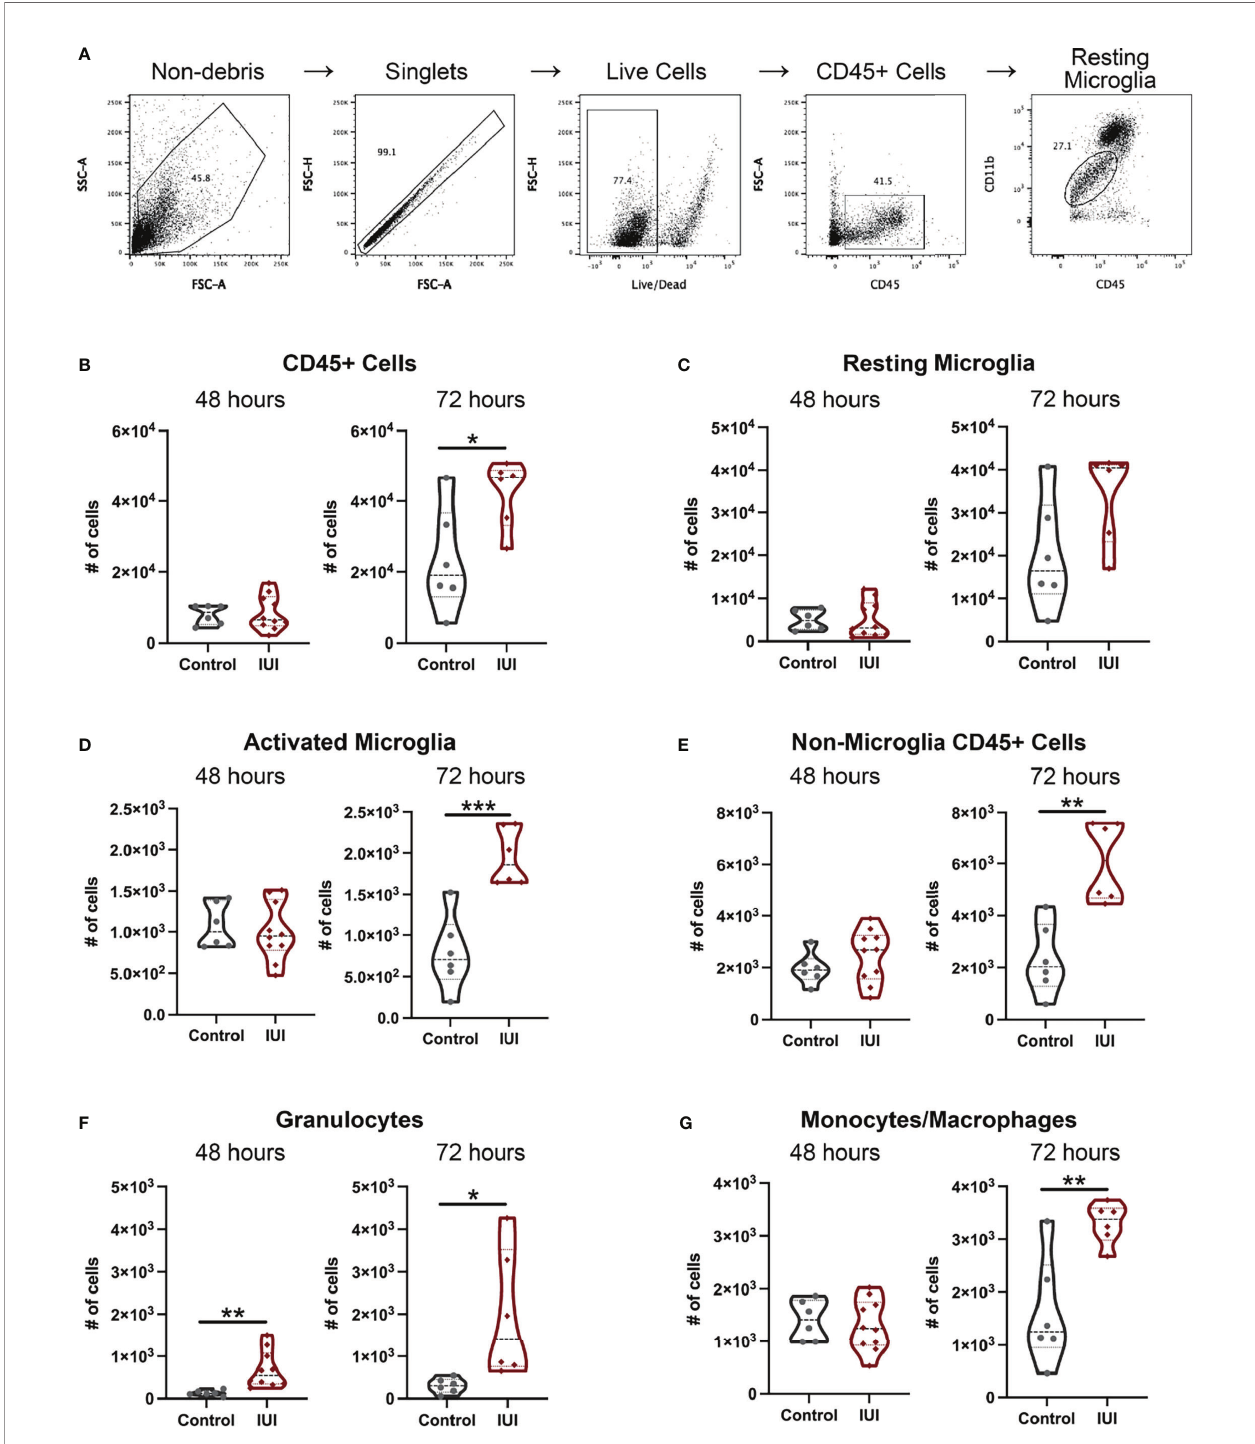
FIGURE 5 | Intrauterine in fl ammation results in fetal microglial activation and an increase in non-microglial immune cells in the fetal brain. Fetal brains were collected at 48 and 72 hours post-uterine injection and processed for fl ow cytometry. (A) The gating scheme used to identify immune cells in the fetal brain is shown. (B) Total CD45+ cells and immune cell subtypes were counted. Subtypes include: (C) resting microglia, (D) activated microglia, (E) all non-microglia CD45+ cells, (F) granulocytes, and (G) monocytes/macrophages. All cell count data was analyzed by Shapiro-Wilk test to establish data distribution. Normally distributed data were analyzed by unpaired t-test and non-normally distributed data were analyzed by Mann-Whitney test. *p<0.05, **p<0.01,